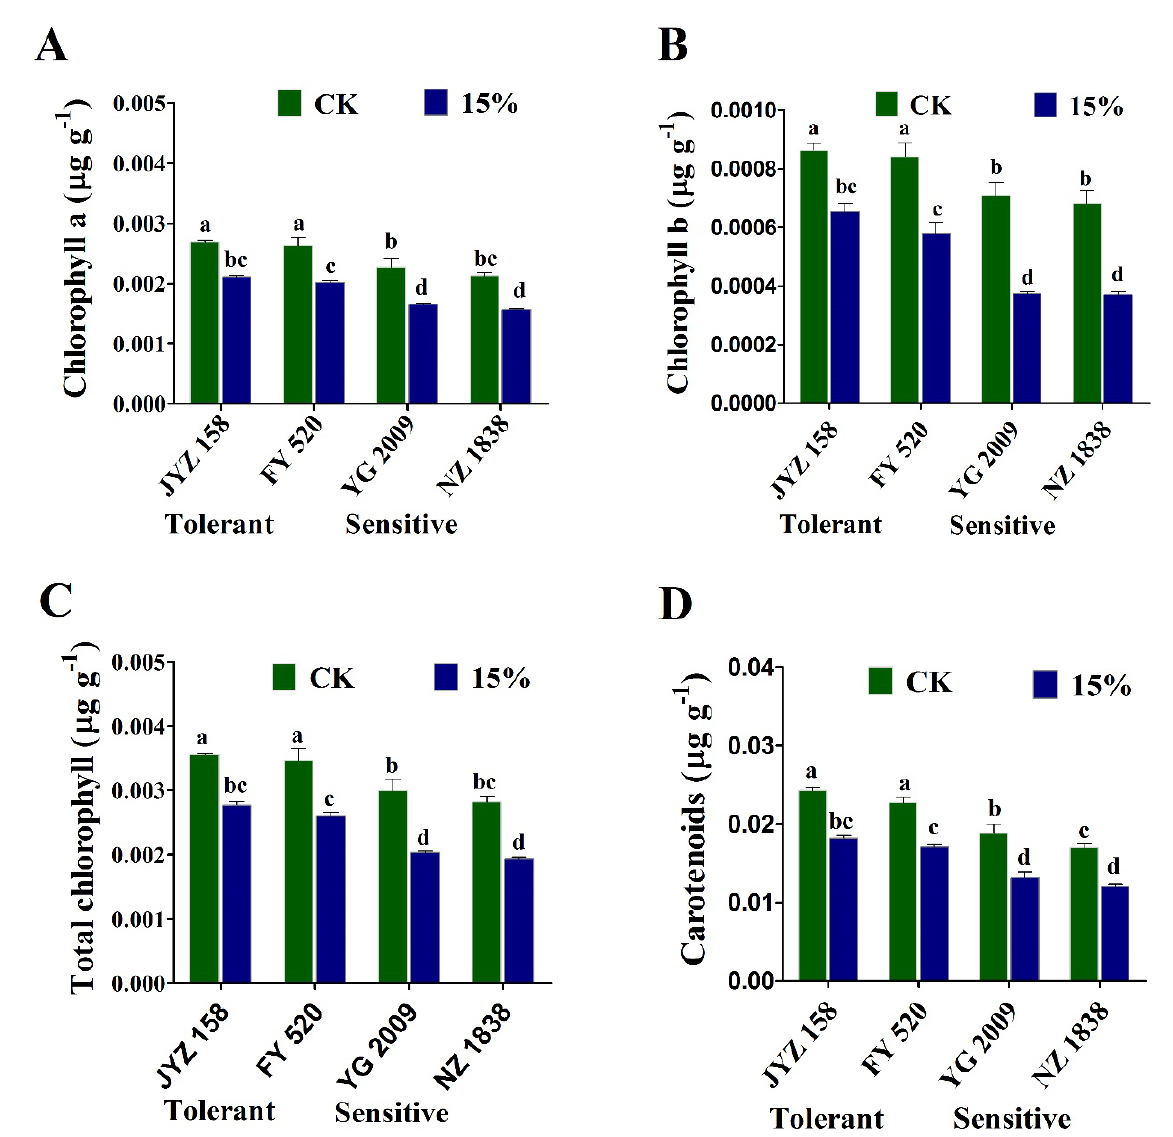
Figure 5. Effects of drought stress (PEG-6000-induced) on ( A ) chlorophyll a, ( B ) chlorophyll b, ( C ) total chlorophyll and ( D ) carotenoids in four rapeseed cultivars during the early seedling stage. Bars represent mean ± SE of three replicates. The different letters indicate significant differences at p < 0.05 using Duncan’s multiple range tests.